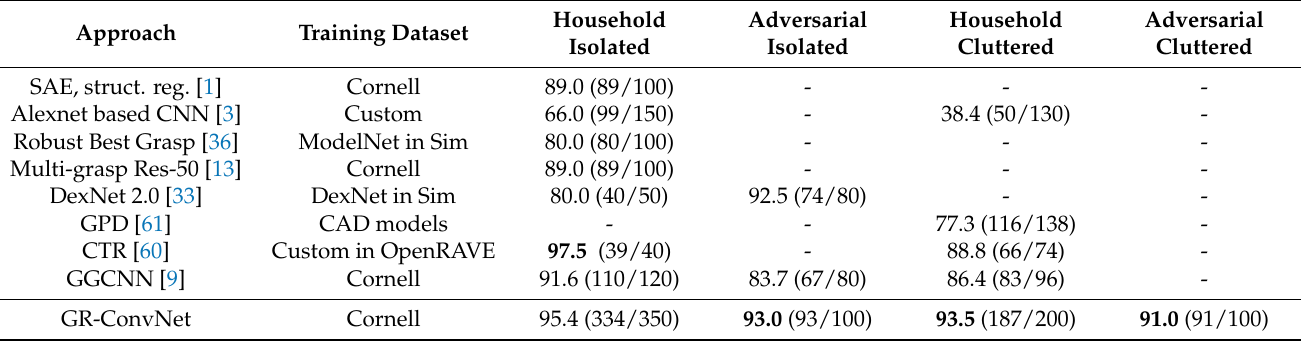
Table 8. Comparative results for grasp success rate (%) in real-world for different